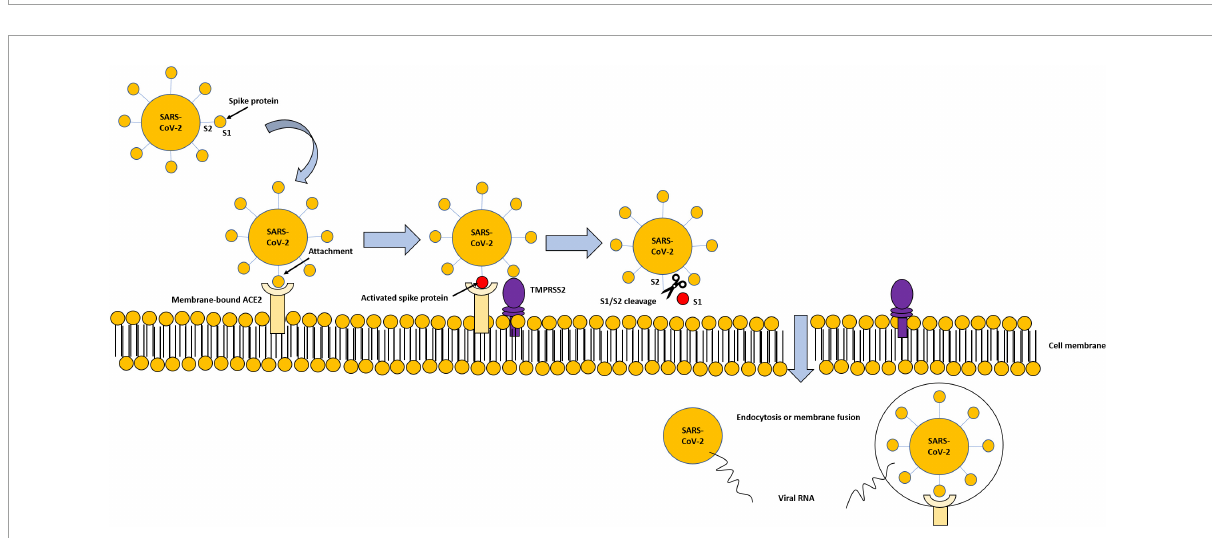
FIGURE2 Modality of virus entry, through ACE2-TMPRSS2 interaction. Viral spike proteins enable attachment to cell-membrane-bound ACE2. TMPRSS2 attacks the S1 unit of the virus S protein and detaches S1 from the S2 unit. The viral S2 unit merges with the host cell membrane, allowing the transfer of the viral content inside the cell through endocytosis or membrane fusion, and subsequent degradation of internalized ACE2.